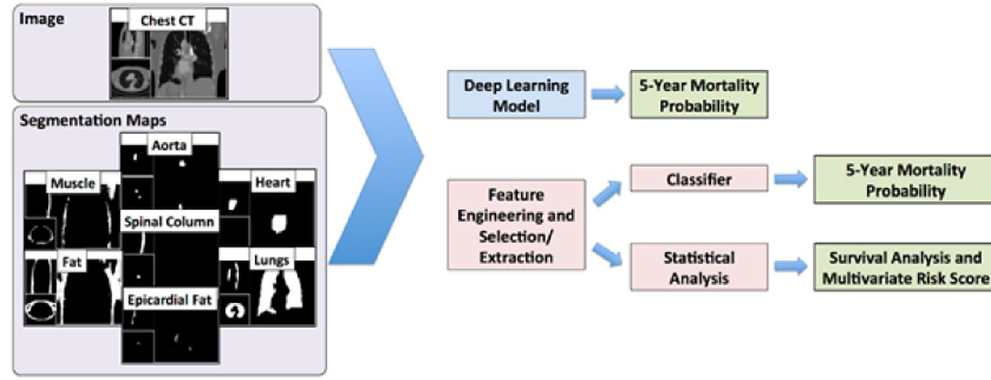
Figure 6. Diagrammatic representation of the analysis pipelines with engineered features and deep learning